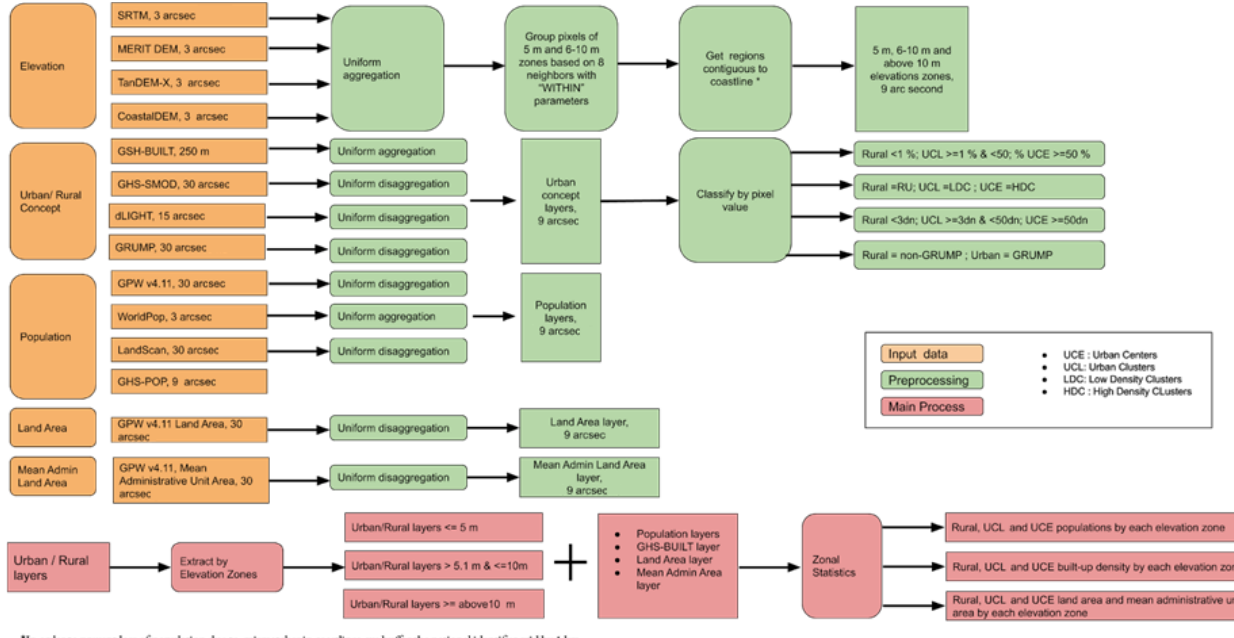
Figure 4. Flow chart describing methods used to construct population and land area along an urban continuum in low-elevation coastal zones